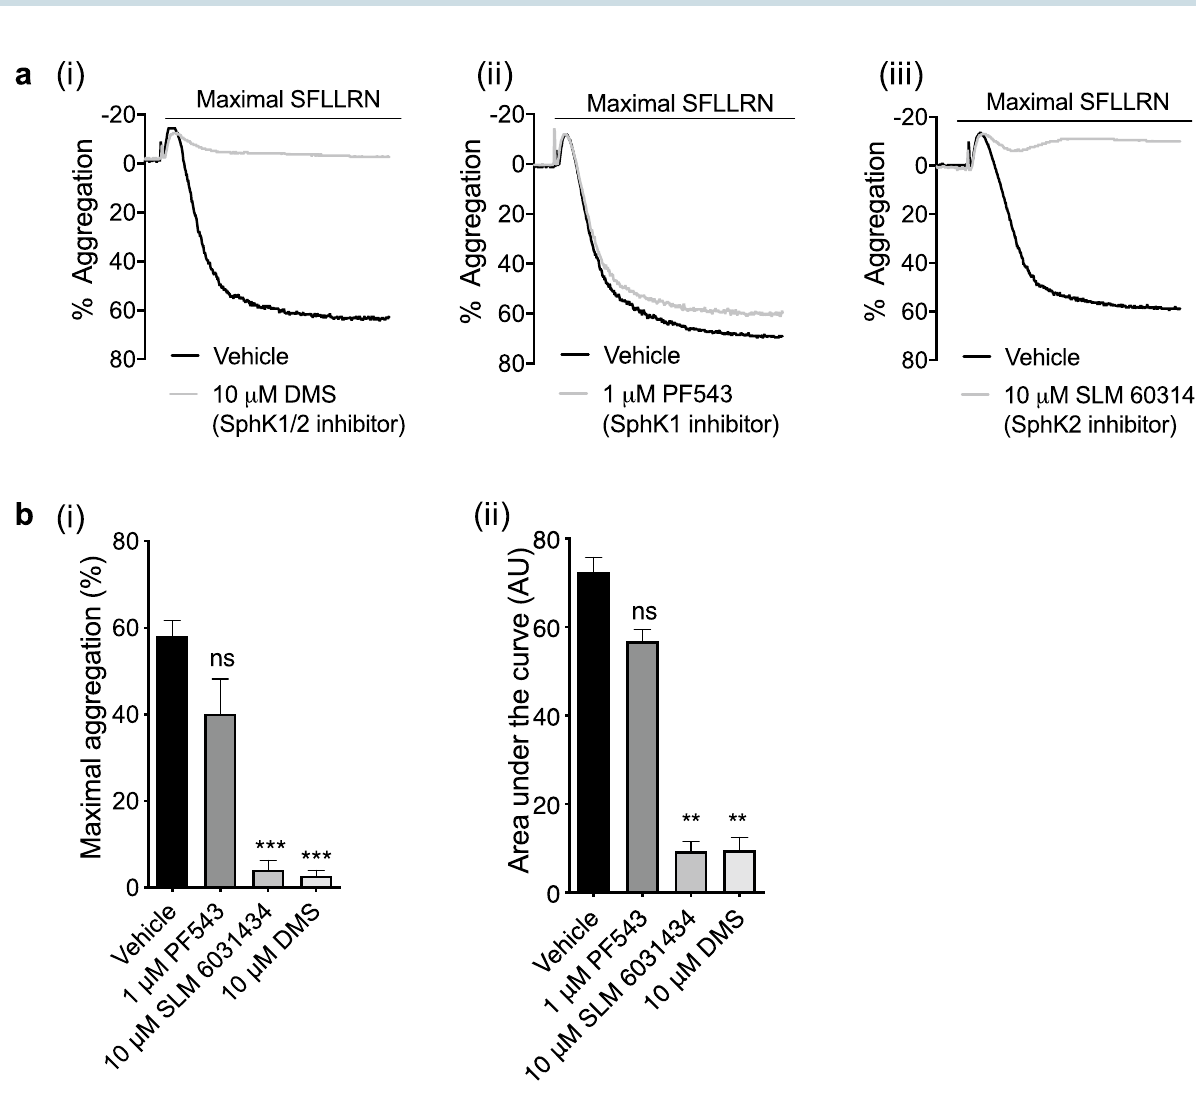
Figure 6. Inhibiting sphingosine kinases reduces PAR1-AP induced platelet aggregation. Washed human platelets (2 × 10 8 /mL) were pre-incubated with vehicle control (0.2% methanol) or sphingosine kinase inhibitors for 5 min. Platelet aggregation was induced by maximal (1.5–2.0 μM) concentration of PAR1-AP and recorded for 5 min. ( a ) Representative traces of maximal concentration PAR1-AP induced platelet aggregation in the absence or presence of (i) 10 μM SPHK1/2 inhibitor DMS (N, N-Dimethylsphingosine), (ii) 1 μM SPHK1 inhibitor PF543 hydrochloride or (iii) 10 μM SPHK2 inhibitor SLM 6,031,434, respectively. ( b ) Bar graphs of (i) quantified percentage aggregation and (ii) AUCs induced by maximal concentration of PAR1-AP alone or in the presence of SPHK inhibitors. AU: arbitrary unit. Data are plotted as mean ± standard error of the mean. N = 5. Statistical analysis: Student’s paired t-test. ns = not significant, * P < 0.05, ** P < 0.01, *** P < to allow fluorescent stain entry. Platelets were loaded with ActinGreen 488 stain for 30 min. The coverslips were mounted using Prolong Diamond Antifade Mountant (Thermofisher Scientific) and set in a dark room overnight. The adhered platelets were imaged using Leica DMI6000 B fluorescent microscope with a 63 × A/1.4 oil objec- tive (Leica Camera AG, Germany). The number of platelets adhered and surface area covered per 1000 μm 2 was determined from three randomly selected fields of view per treatment condition using ImageJ software. The per- centage of platelets in each phase (phase I = compact shape, phase II = Filopodial extension, phase III = filopodial extension and spread, phase IV = fully spread 55 ) was assessed by counting the platelets in each phase and dividing by the total number of platelets. An average from three replicates per sample was calculated. Data analysis. Data were analysed using GraphPad Prism 7 software (GraphPad Software, California, USA). All data are presented as the mean ± standard error of the mean with at least three independent experiments. Statistical tests used were as indicated in the figure legends, using a parametric test where data was normal and a non-parametric test where data did not show a normal distribution. We consider a P value of < 0.05 as signifi- cant. Concentration–response curves were plotted with a four-parameter logistic equation.